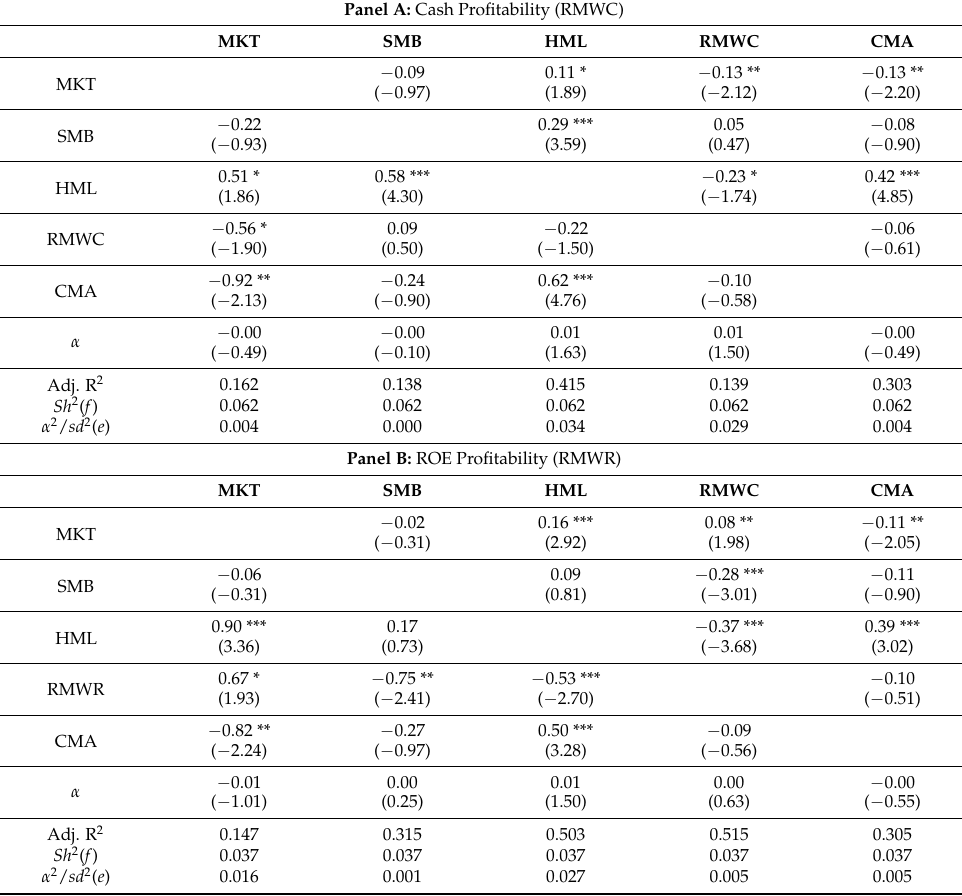
t -statistics in parentheses. *** p < 0.01, ** p < 0.05, * p <